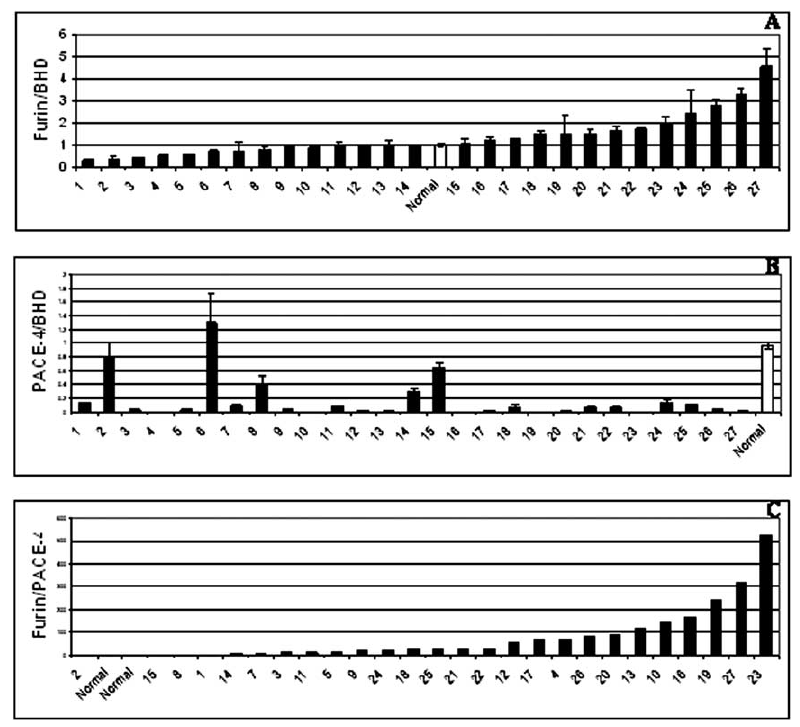
Fig. 4. Real-time PCR for furin (A) and PACE4 (B). Thirty percent of the samples had increased levels of furin. Most of the tumors expressed significant lower levels of PACE4 than the normal controls. (C): Ratio of furin to PACE4 expression. Note that furin is expressed in higher proportion than